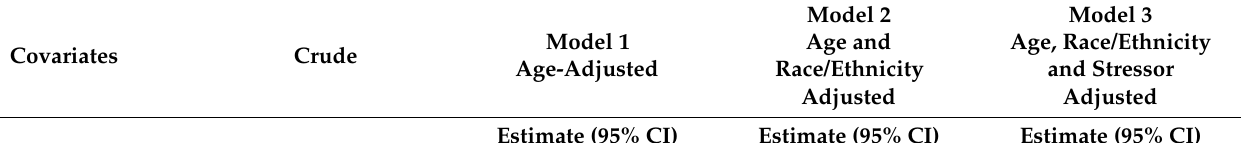
Table 1. Associations between age, race/ethnicity, stressors, resources (non-psychological and psychological), and self-reported psychological resilience from participants in the Women’s Health Initiative Extension Study. Note, each row shown corresponds to an individual fitted